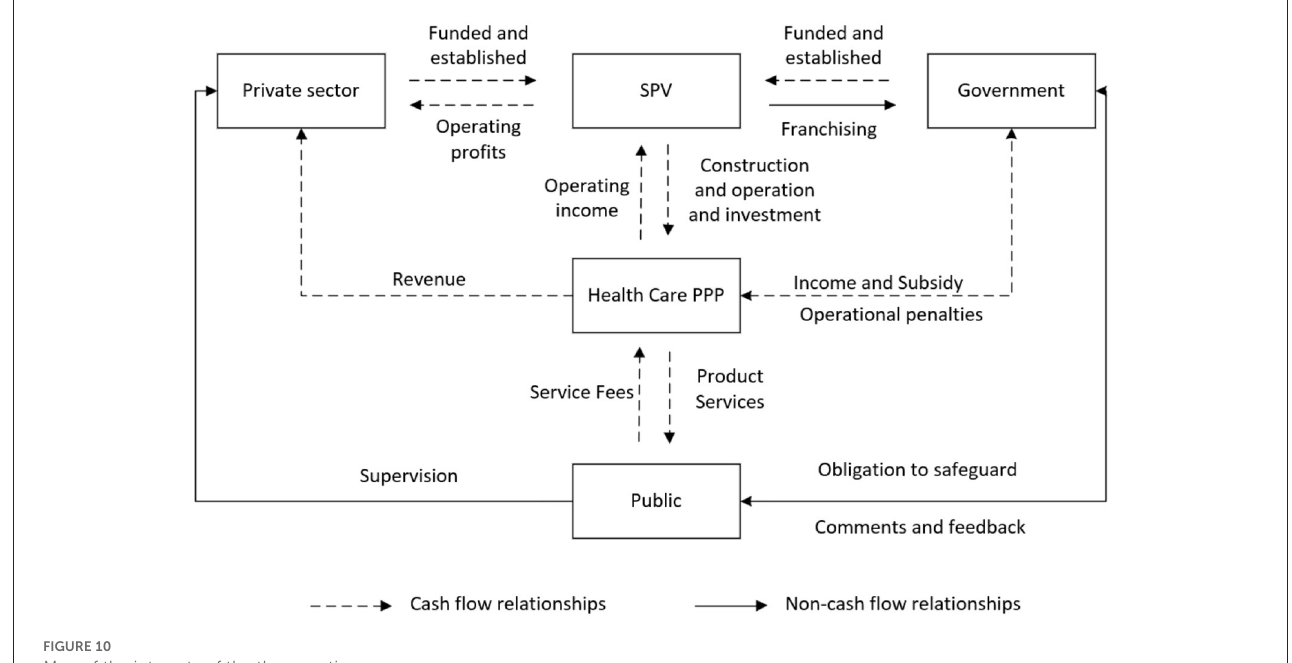
FIGURE10 Map of the interests of the three